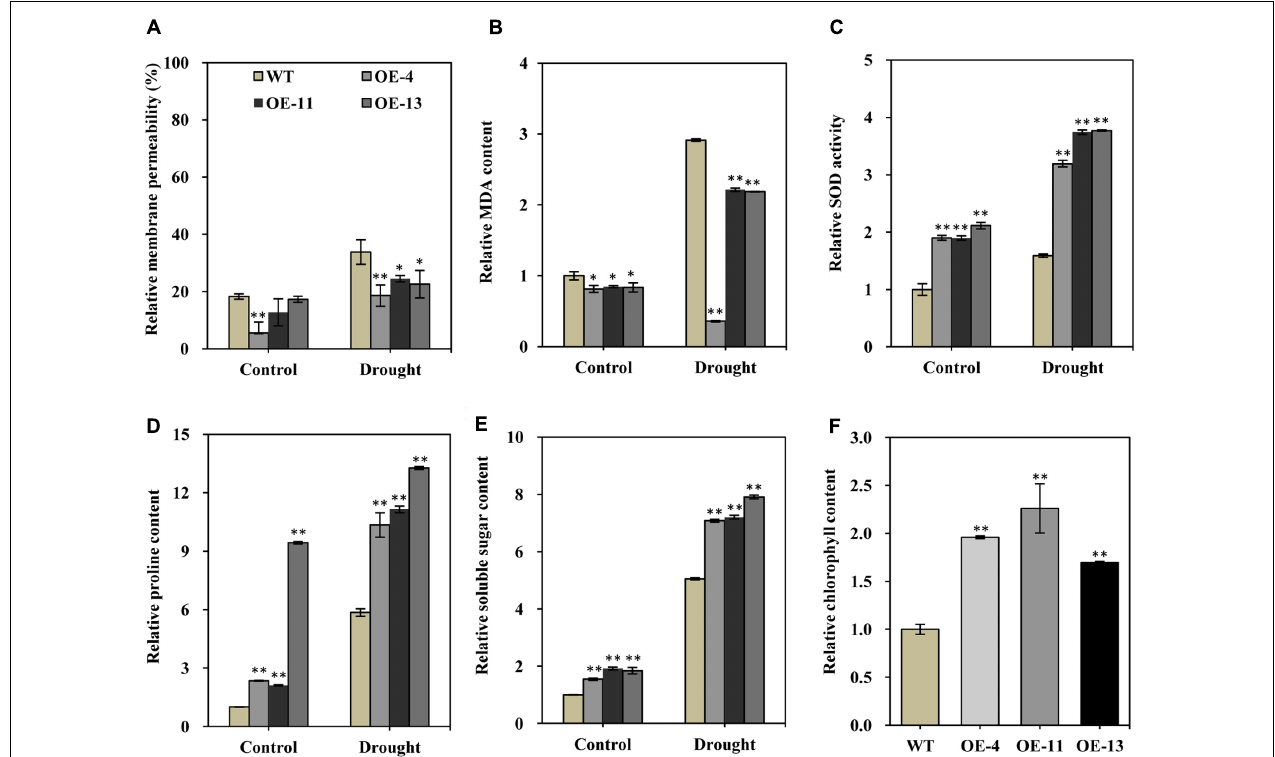
FIGURE 6 | Relative membrane permeability, MDA content, SOD activity, soluble sugar content, proline content, and chlorophyll contents of wild type and transgenic alfalfa plants before and after drought stress treatment. Comparison of leaf membrane permeability (A) , MDA content (B) , SOD activity (C) , proline content (D) , soluble sugar content (E) , and relative chlorophyll content (F) of wild type and transgenic alfalfa plants before and after 20-day drought treatments. Values are means ± SD of three replicates ( ∗ P < 0.05, ∗∗ P <